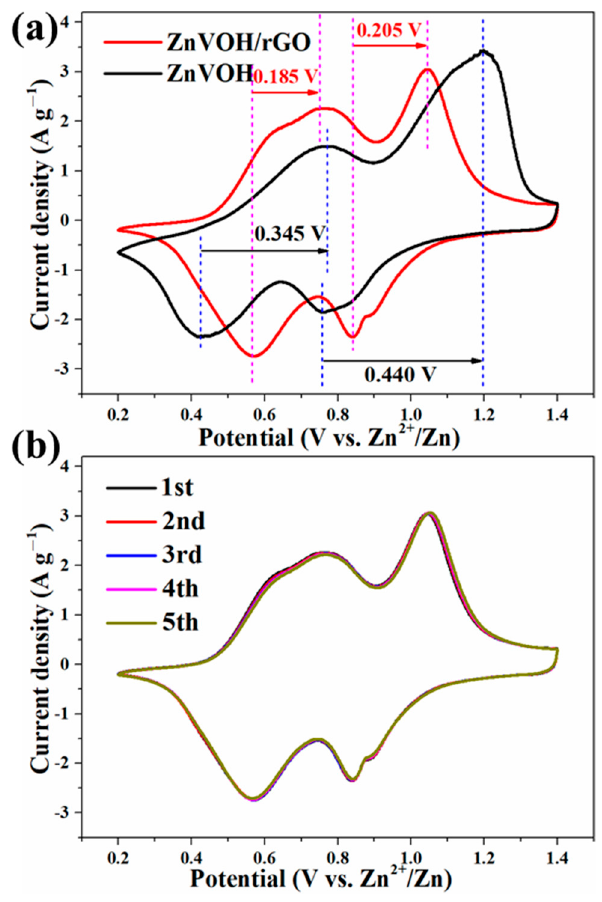
Figure 4. ( a ) Comparative CV curves of ZnVOH and ZnVOH/rGO; ( b ) CV curves of ZnVOH/rGO at the first 5 cycles.